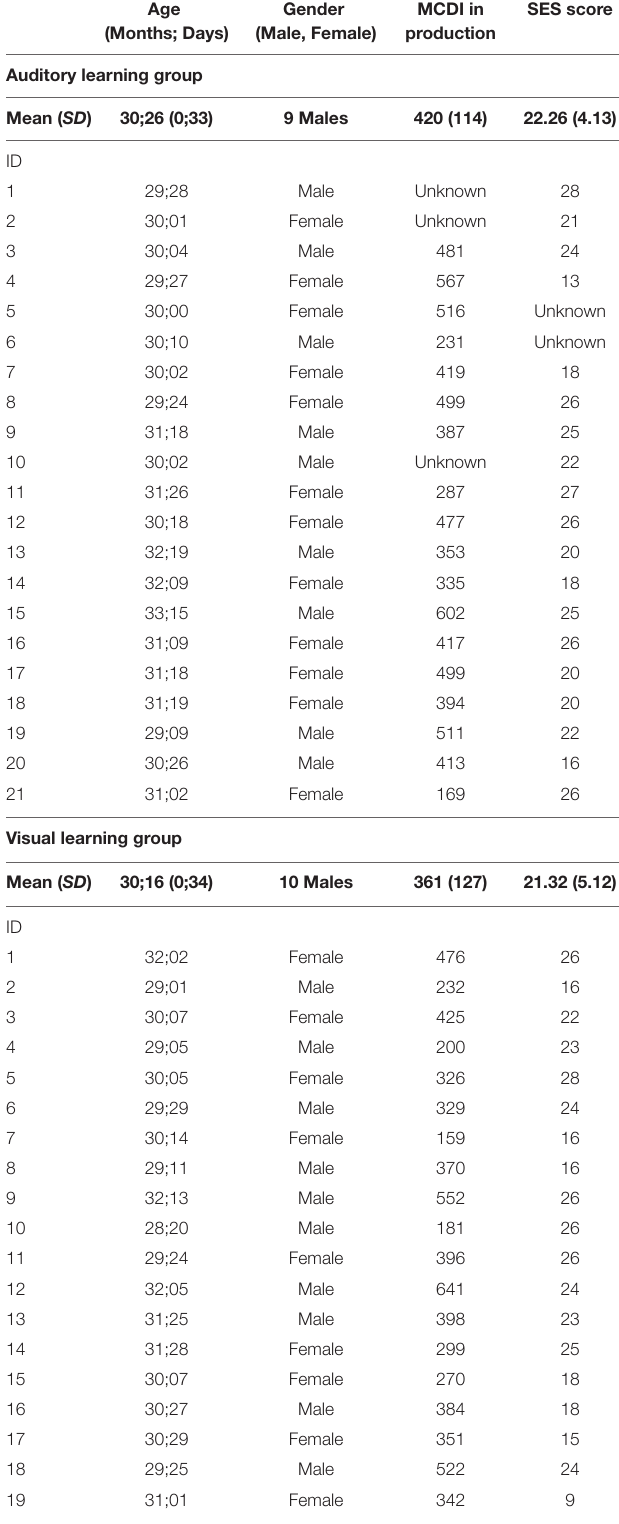
TABLE 1 | Demographic information including the participant’s identification (ID), the age (Months; Days), the gender (Male, Female), the MCDI estimation of the expressive vocabulary size and the socio-economic status (SES) as well as the mean and standard deviation (SD) for each